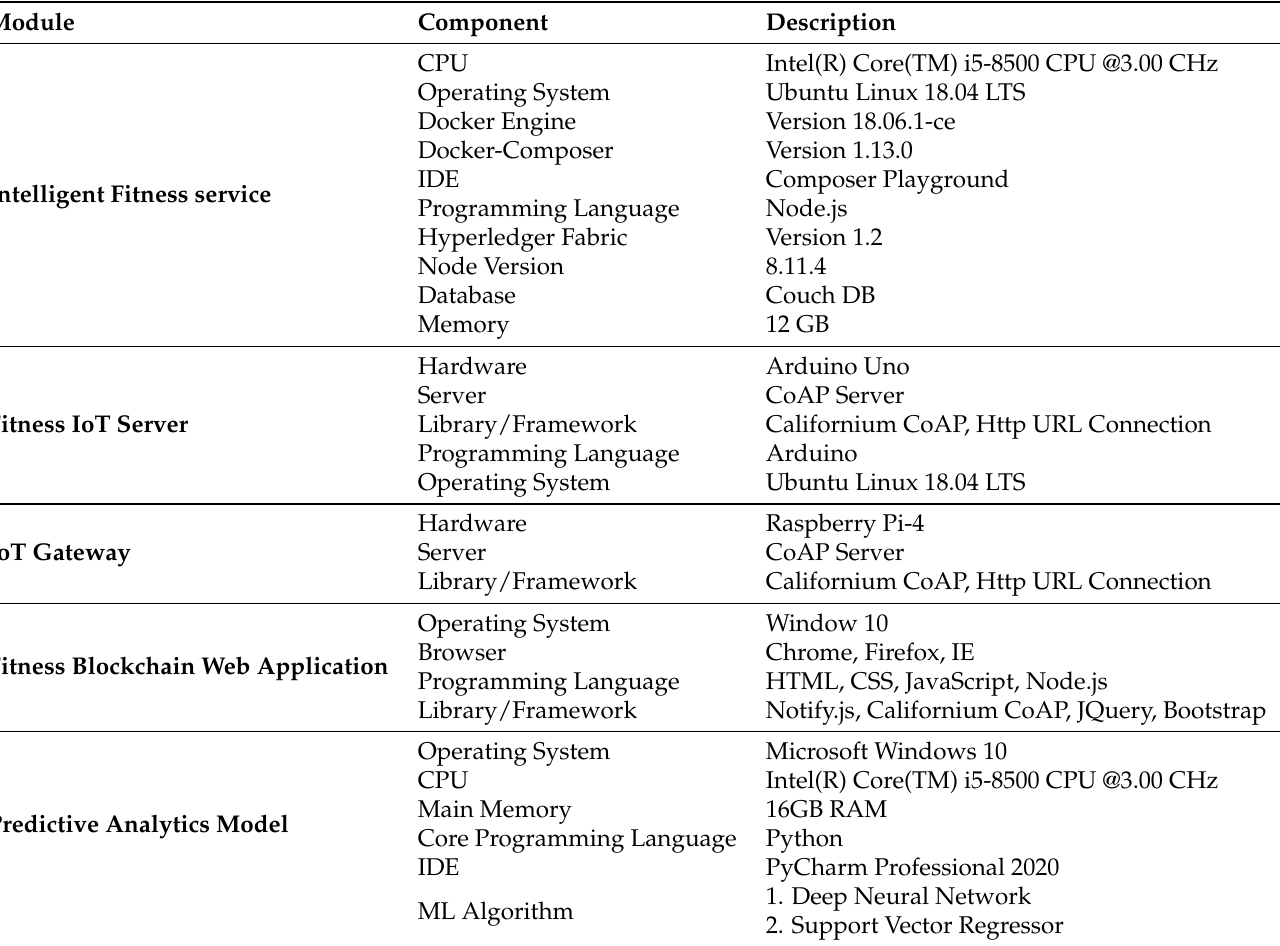
Table 6. Development environment for the intelligent fitness service based on enhanced smart contract enabled relationship and inference engine in IoT